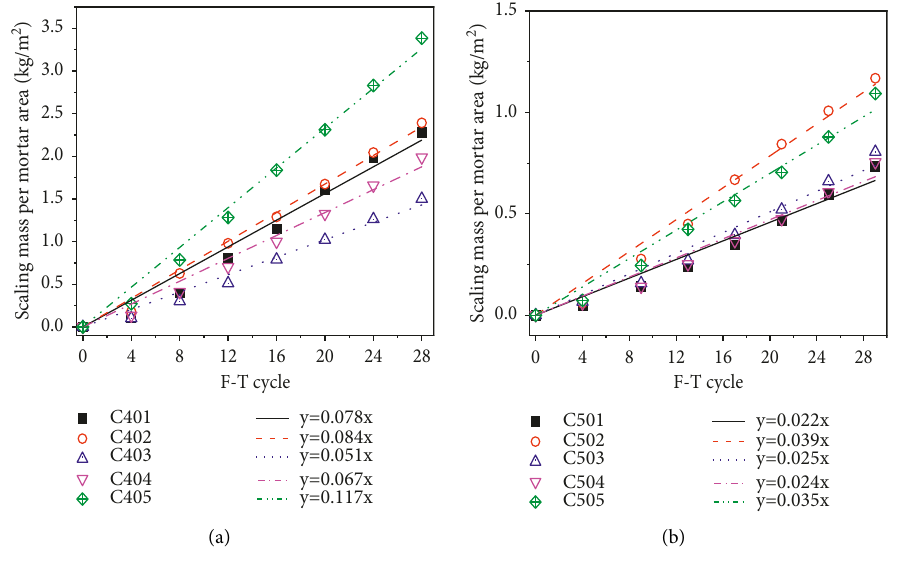
Figure 6: Scaling mass per mortar area at 90 d.